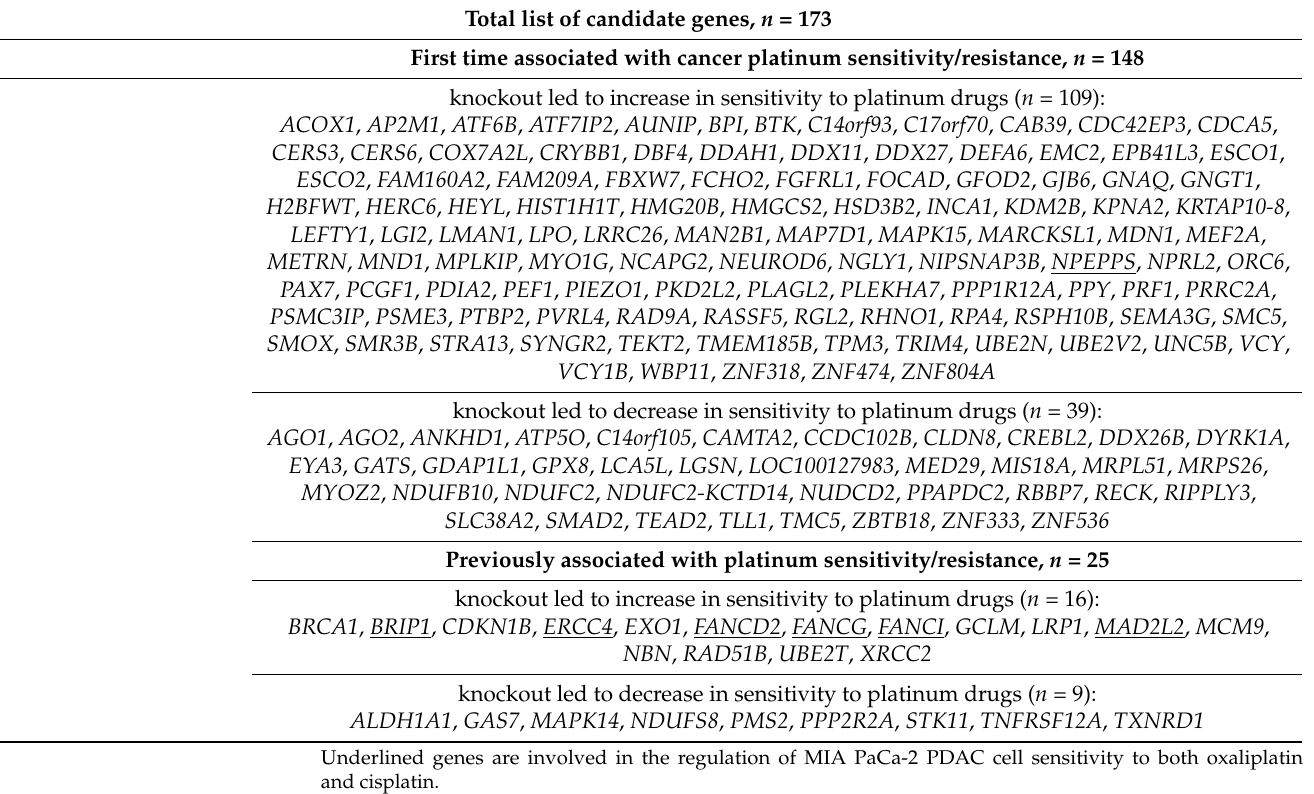
Table 3. Summary results of the performed CRISPR/Cas9 screenings of MIA PaCa-2 pancreatic cancer cells with cell cycle/nuclear proteins and genome-wide sgRNA libraries (showing genes for which at least 2 sgRNAs changed representation in ≥ 2 folds, FDR ≤